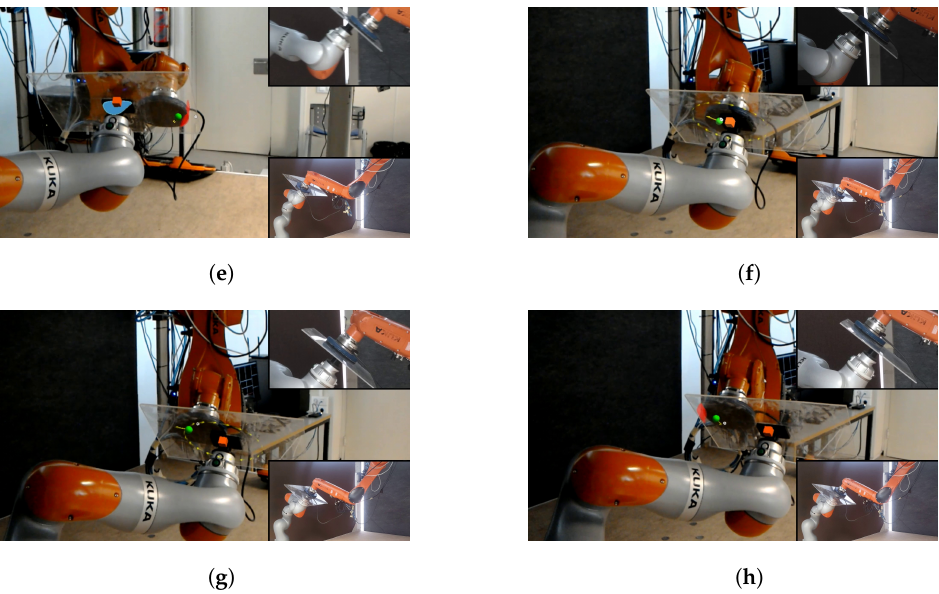
Figure 17. Fourth experiment: frames of the video showing the simultaneous teleoperation of both robots with the proposed AR-based interface. See the video at https://media.upv.es/player/?id=29 330720-8a8b-11ec-97cd-ab744f931636 (accessed on 26 April 2022) [84]. ( a ) Video: 1 m 19 s. ( b ) Video: 1 m 44 s. ( c ) Video: 1 m 54 s. ( d ) Video: 1 m 55 s. ( e ) Video: 2 m 13 s. ( f ) Video: 2 m 42 s. ( g ) Video: